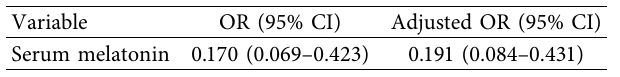
Figure 3: Receiver operator characteristic (ROC) curve of serum melatonin. The ROC curve was plotted to determine the cut-off point for serum melatonin that distinguishes the MCI and non- MCI in diabetic patients. MCI: mild cognitive impairment. Table 5: The risk of cognitive impairment in T2DM patients with high serum